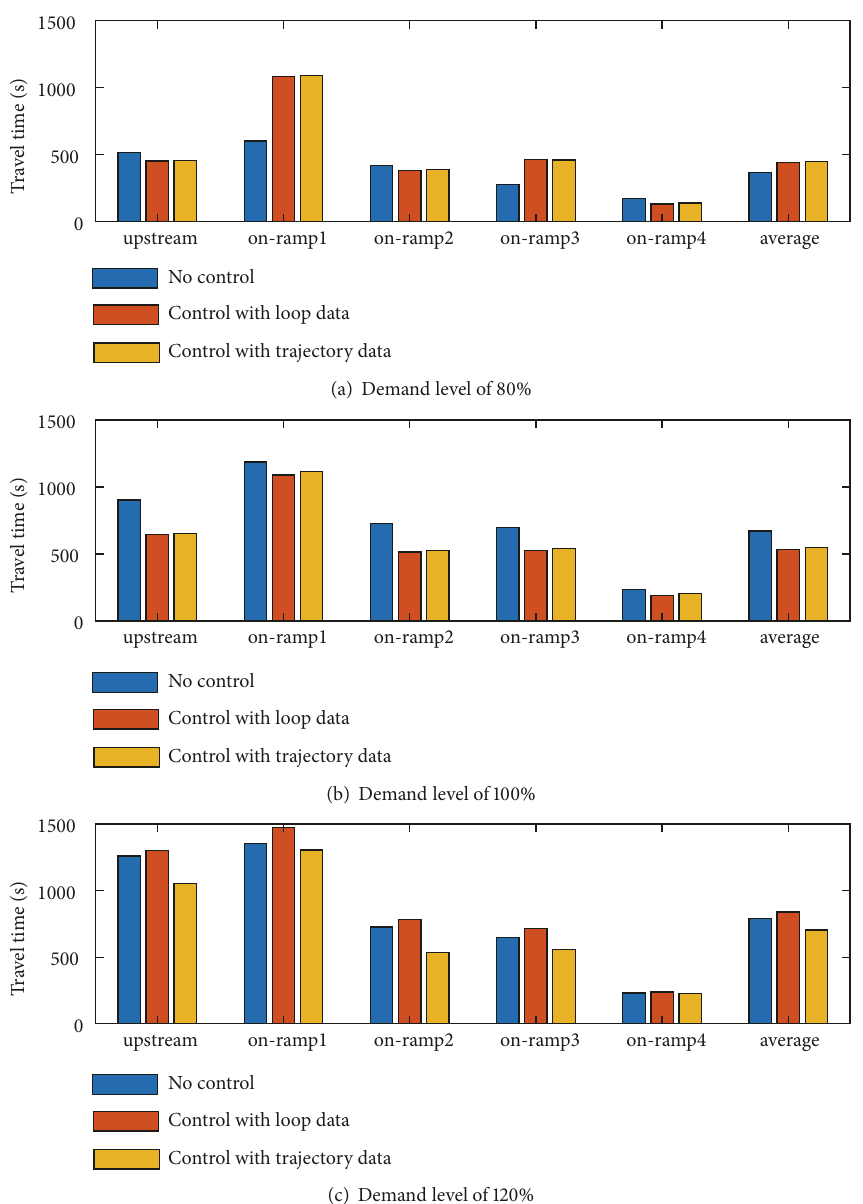
Figure 11: The travel time of vehicles from different